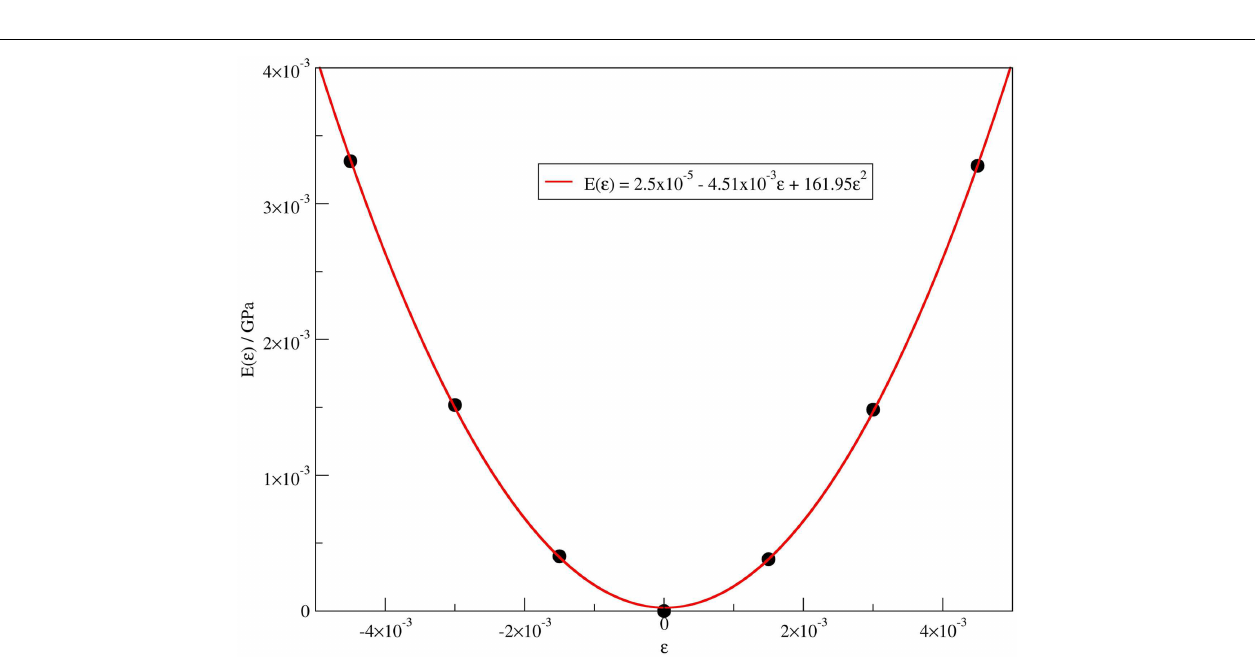
side of the NTs. There are 24 silanol groups in each unit cell of (12,0), arranged in two alternate radial lines. Hydroxyls in the same radial line have distances of 3.4 Å and, in between different